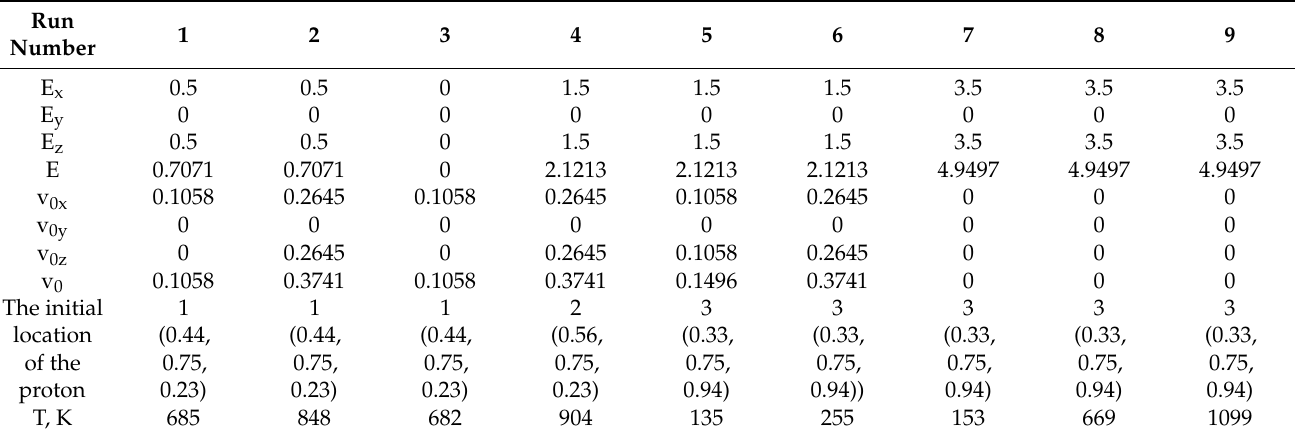
Table 1. Characteristics * of the initial data and the calculated temperatures for the series of ab initio molecular dynamics calculations.